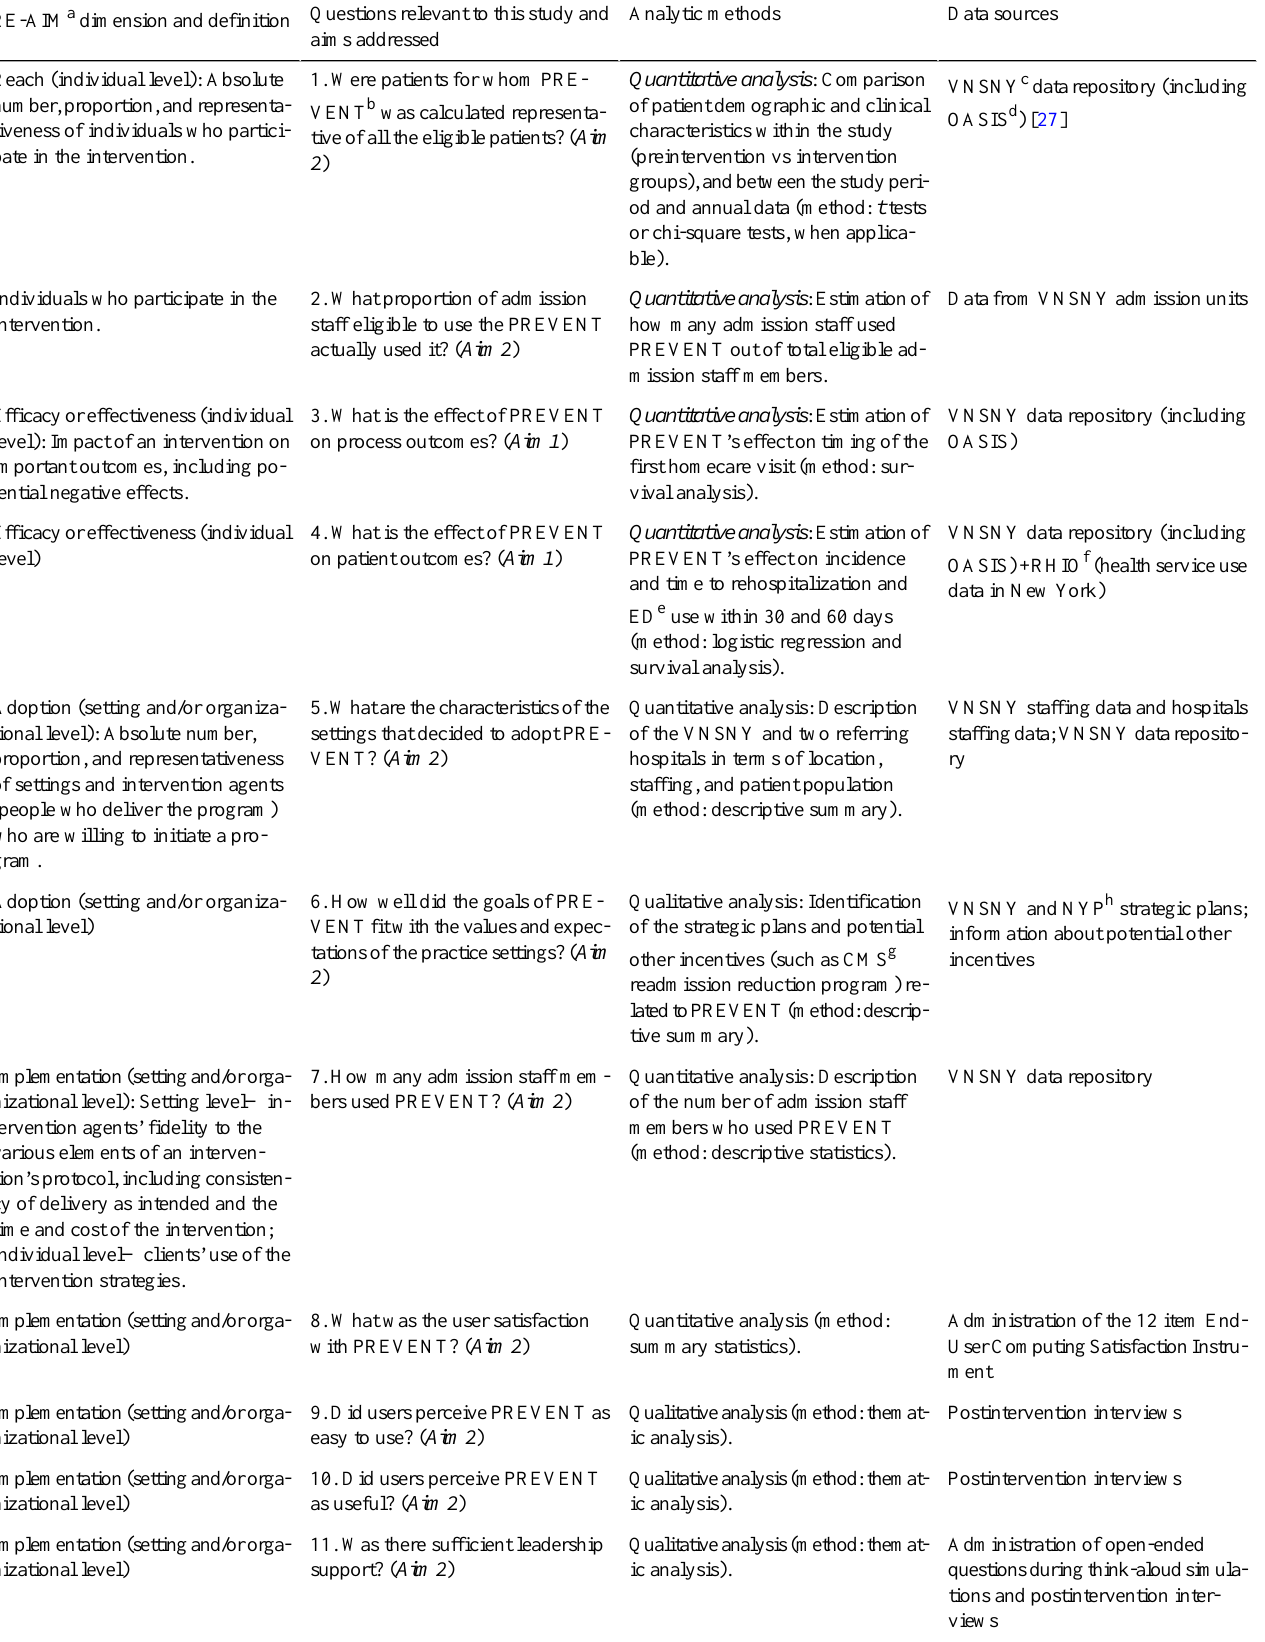
Table 1. Reach, Effectiveness, Adoption, Implementation, and Maintenance framework dimensions in this study.